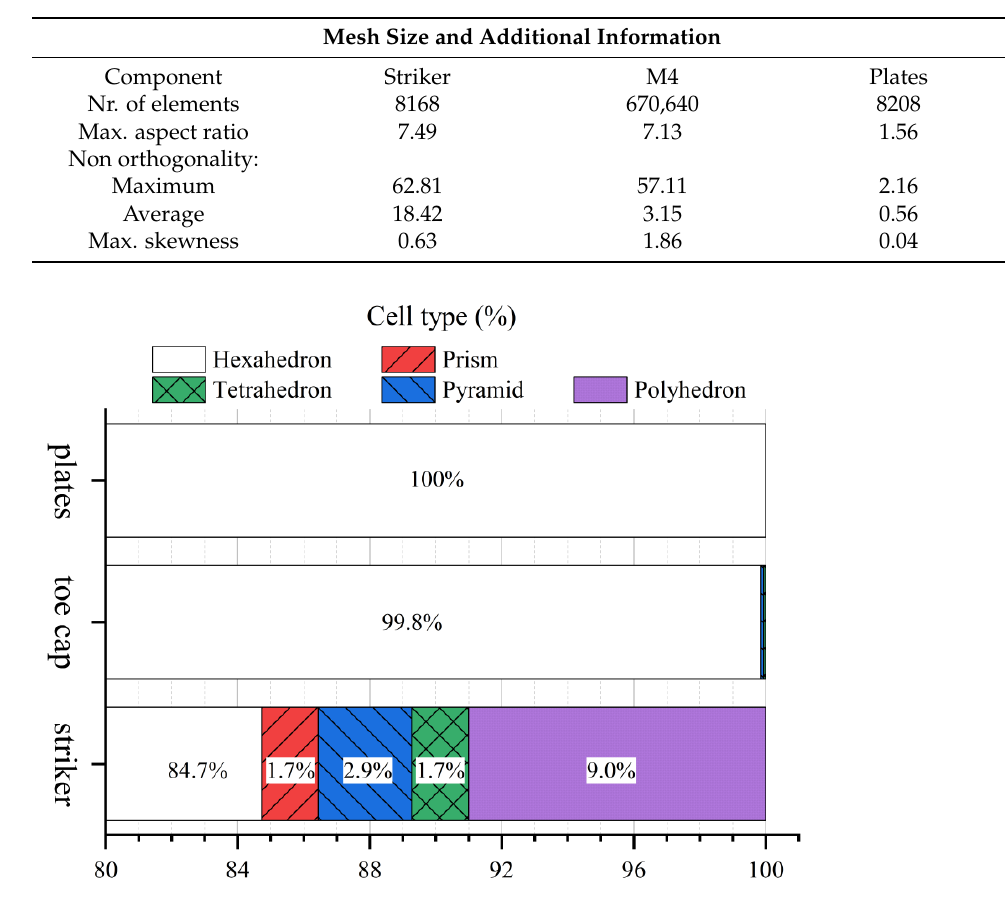
Figure 6. Percentage of cell type distribution.